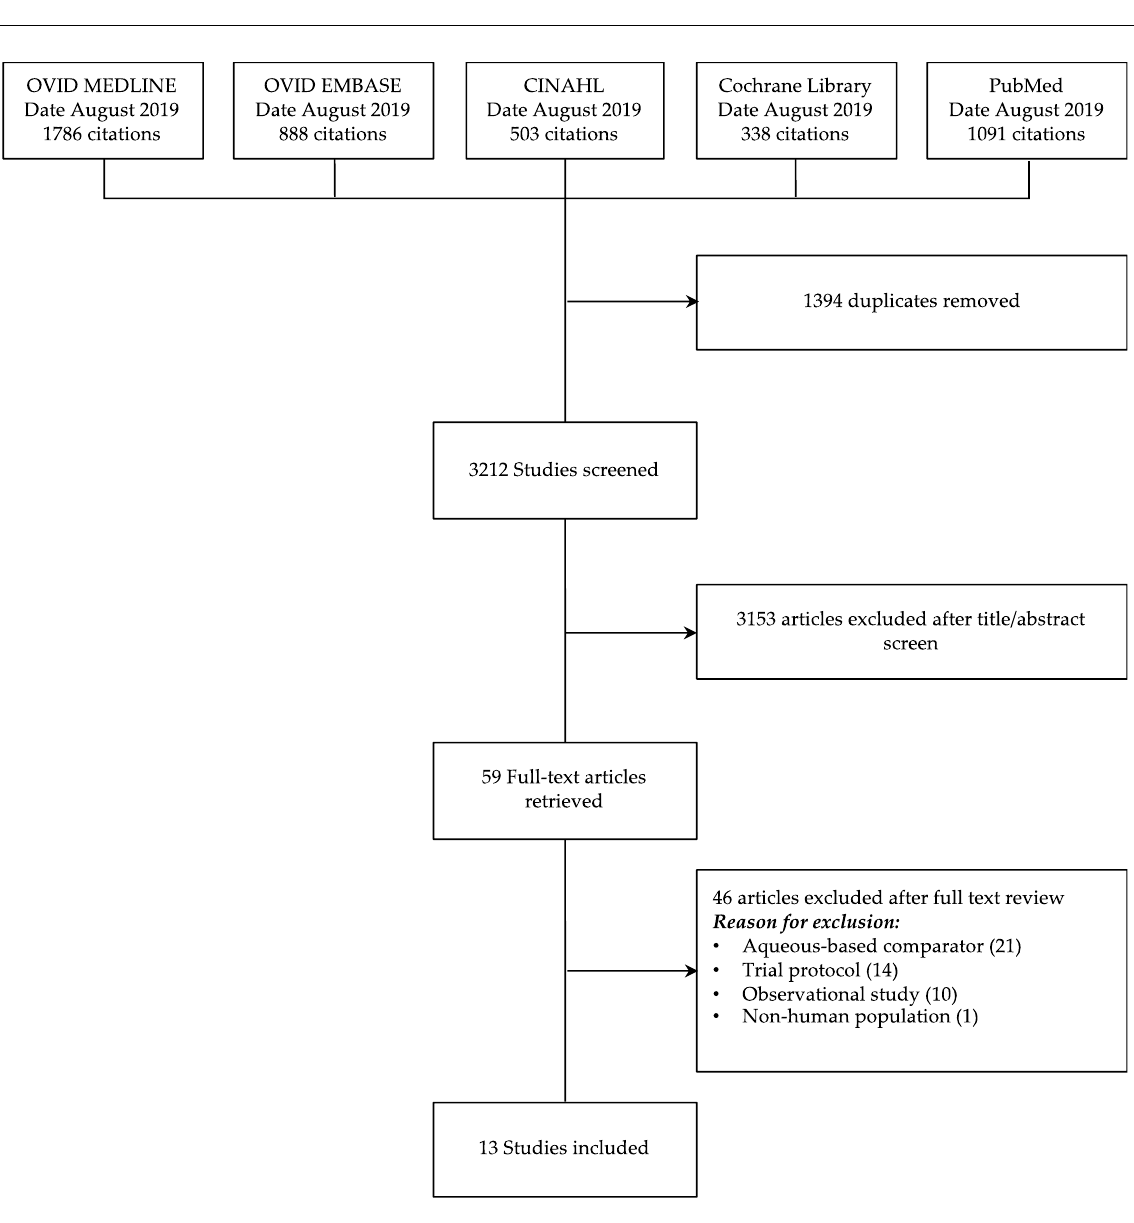
Figure 1 . PRISMA Flow Chart of Systematic Review and Study Selection. Figure 1. PRISMA Flow Chart of Systematic Review and Study